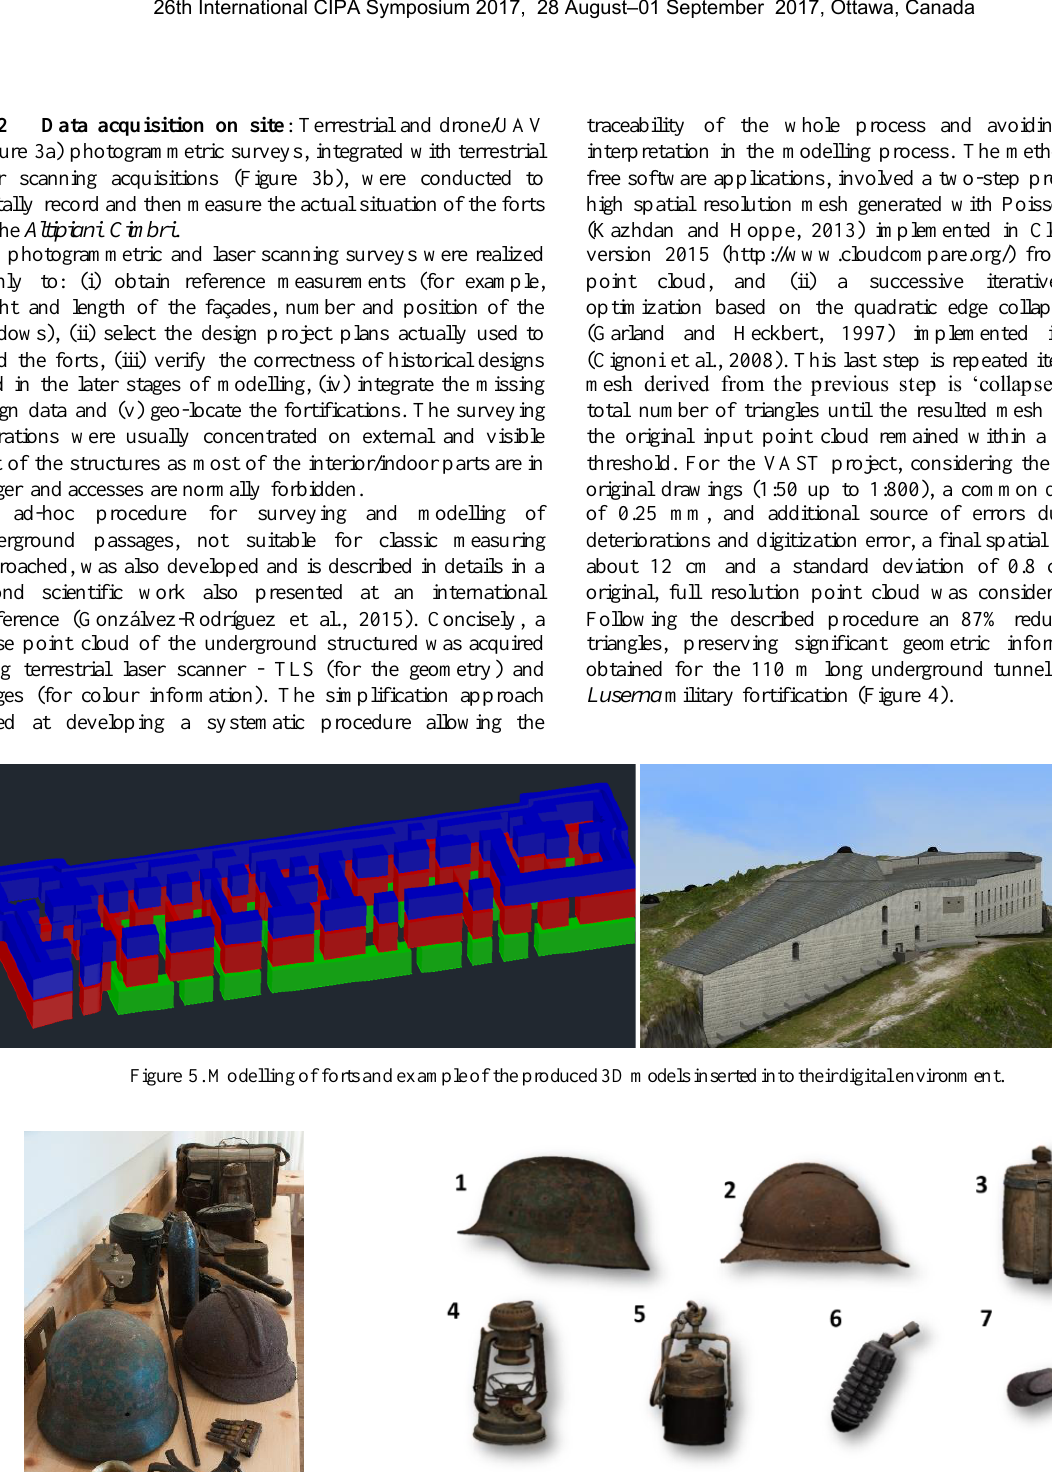
(Figure 3a) photogrammetric surveys, integrated with terrestrial laser scanning acquisitions (Figure 3b), were conducted to